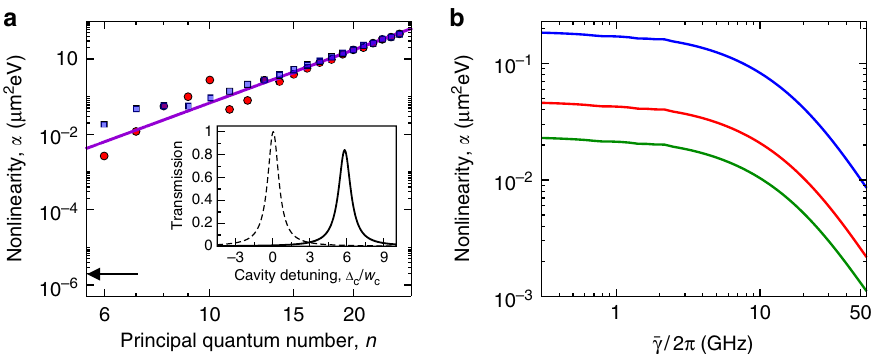
Fig. 2 Optical nonlinearity induced by Rydberg interactions. a Integrated interaction strength α for the m = 1 excitonic series at the K + - (red) or K − -point (blue) of the Brillouin zone with Ω /2 π = 60 GHz, γ ¼ γ = n 3 and the remaining parameters as in Fig. 1, i.e., g /2 π = 5561 GHz 31 , Δ /2 π = 700 GHz, and γ /2 π = 300 GHz. The solid line shows the α ~ n 14/3 scaling found for both K -points which results from the large-distance ~ n 11 dependence of the Rydberg exciton interaction and the considered γ (cid:4) n (cid:2) 3 decrease of their linewidth 12 . For lower principal quantum numbers, however, the interaction strength features a signi fi cant valley dependence. For comparison, the arrow indicates the nonlinearity measured 10 for ground-state excitons in GaAs. The inset shows corresponding transmission spectra upon changing the cavity frequency for n = 10 in the linear regime (dashed line) and for small driving Ej j 2 ¼ 2 : 5 ´ 10 (cid:2) 5 μ m − 2 (solid line). Both curves are scaled by the maximum of the linear transmission line. The cavity detuning Δ c is shown in units of the width w c of the linear transmission line. b illustrates that the nonlinearity persists in the presence of signi fi cant Rydberg state broadening, γ , as shown for n = 10, γ /2 π = 300 GHz (blue), γ /2 π = 1200 GHz (red) and γ /2 π = 2400 GHz (green) with Δ = 2 γ and at constant Ω 2 Γ j j ¼ 40